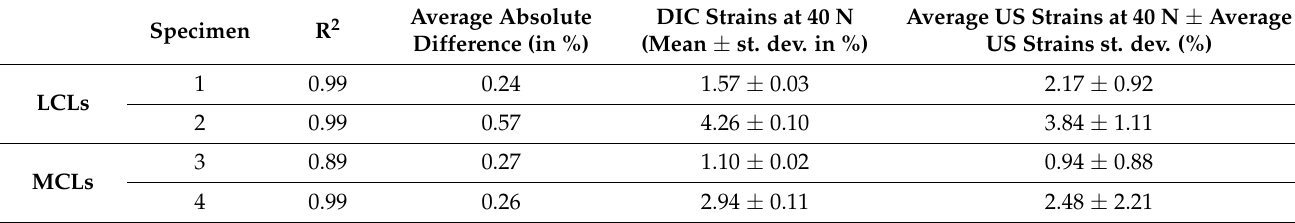
Table 4. Individual results of all valid specimens from the “validation” group processed with the optimal parameter set for each ligament. Results included the linear correlation coefficient (R 2 ) between the digital image correlation (DIC) and ultrasound (US) strains, average absolute difference over all loading ranges (in %) and within-specimen average strains at 40 N for both the DIC and US ± standard deviation in